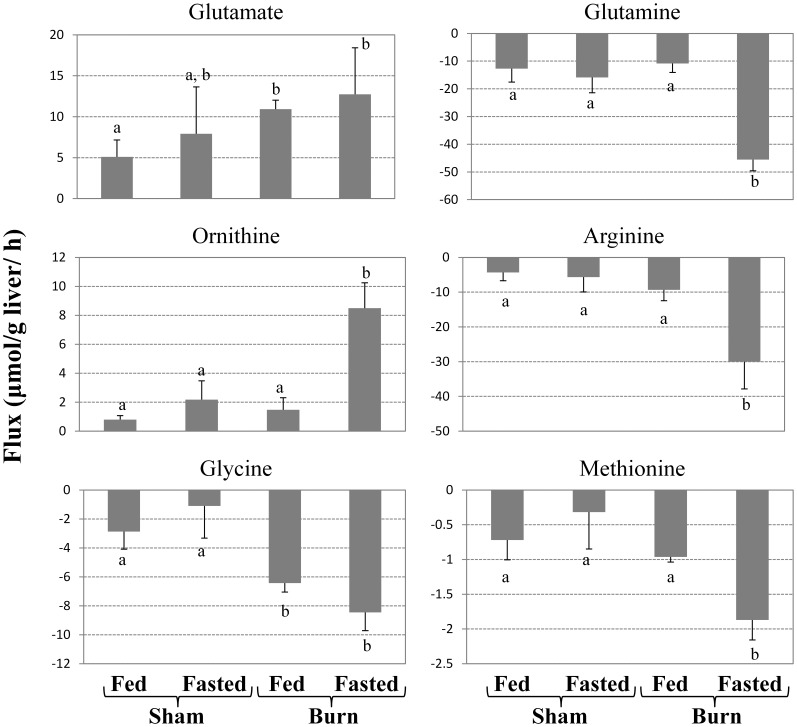
Average fluxes for the main amino acids in perfused livers.Bars above and below indicate net production and uptake, respectively. Data shown were obtained from the slope of linear fits of measured perfusate concentrations vs. time normalized to liver mass. Bars labeled with different letters are statistically significantly different (ANOVA, P<0.05; N≥3) from each other. Data shown are means±SD.